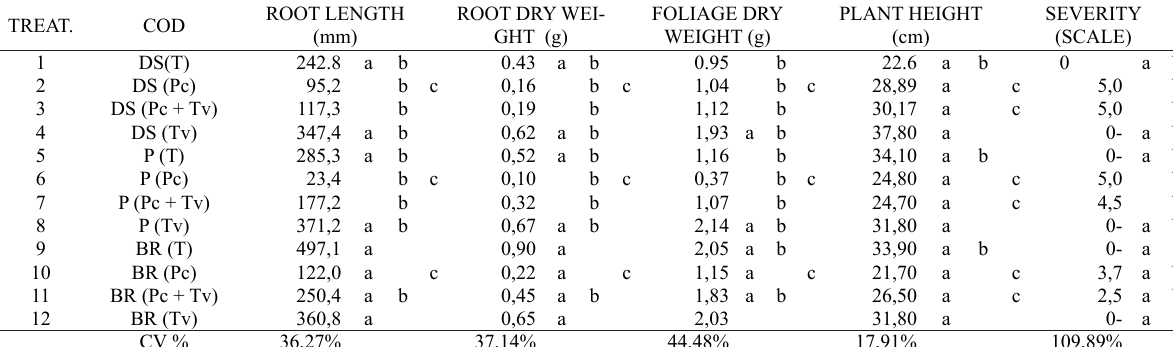
Table 1. Average of evaluated parameters for the efficiency test of T. viride as a bio controller for P. capsici under three sowing methods in Pepper.